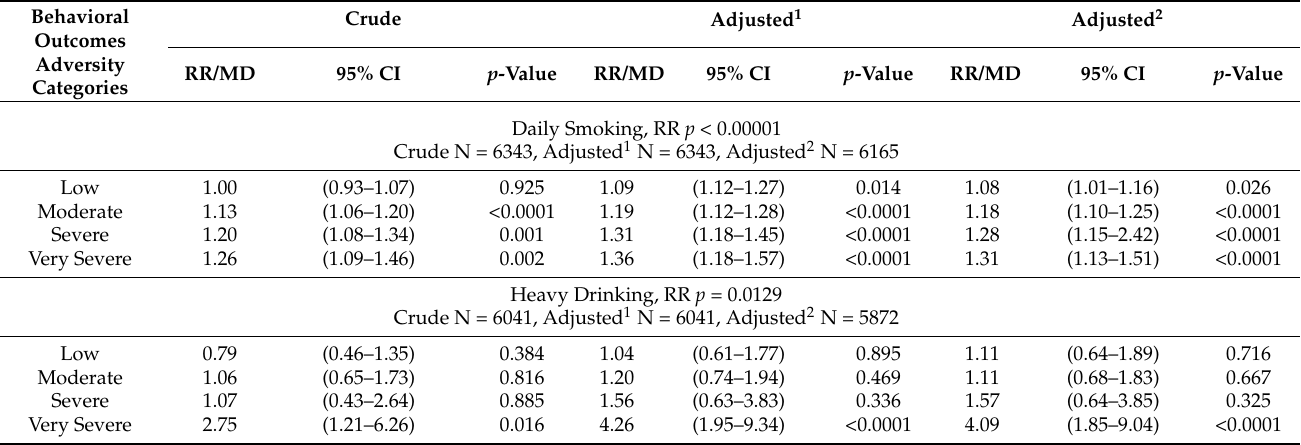
Table 7. Risk Ratio and Mean Differences between WICAC and behavioral